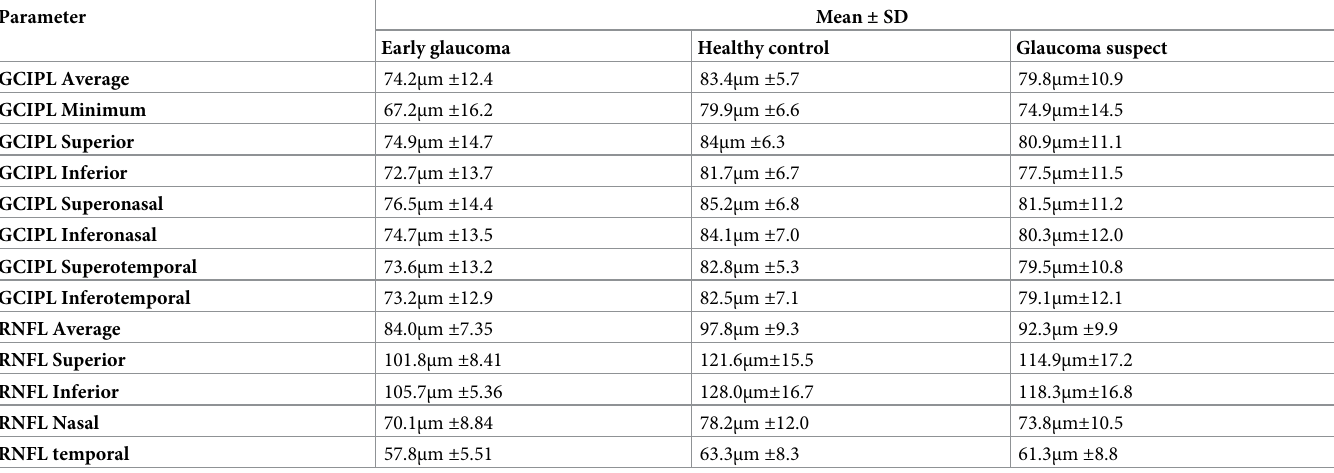
patients (3.2%) and no participant was taking steroid ’’Table 1’’. On comparison of GCIPL parameters among glaucoma suspects and healthy controls, all GCIPL quadrant thicknesses were significantly different except superior and temporal quad- rant. In contrast to the observed large differences in GCIPL parameters among early glaucoma and controls, the differences were less marked among glaucoma suspects and controls. All RNFL parameters were different significantly in these groups. Compared to GCIPL parame- ters, the observed differences were larger in RNFL parameters (22.3) among suspects and con- trols. Of the RNFL parameters, the largest difference was observed on the inferior quadrant ’’Tables 2 and 3’’. The overall diagnostic accuracy of combined and individual GCIPL and RNFL parameters were tested by receiver operating curve (ROC). For detection of early glaucoma from healthy controls, the combined or logic (that requires either RNFL OR GCIPL to be abnormal) and all of the GCIPL parameters had good diagnostic performance with all having AUROC above 0.7. Among the RNFL parameters, superior and temporal thickness had poor performance (0.682, 0.647 respectively) while the average, inferior and nasal thickness had good diagnostic Table 2. Mean ± standard deviation of GCIPL and RNFL